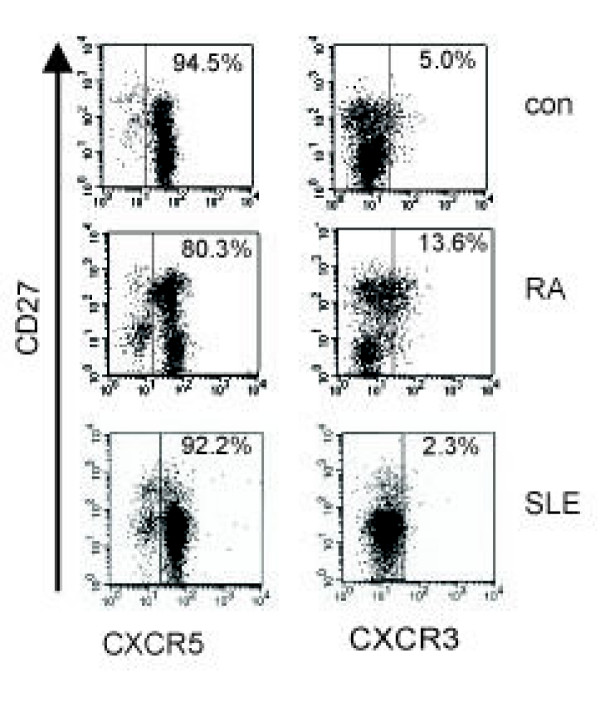
Modulation of CXCR3 and CXCR5 expression in patients. A representative fluorescence-activated cell sorting analysis for chemokine receptor expression on peripheral B cells (CD19+) is shown. The percentages of CXCR5+ and CXCR3hi B cells are given for healthy controls (con) and patients with osteoarthritis (OA), rheumatoid arthritis (RA) and systemic lupus erythematosus (SLE).